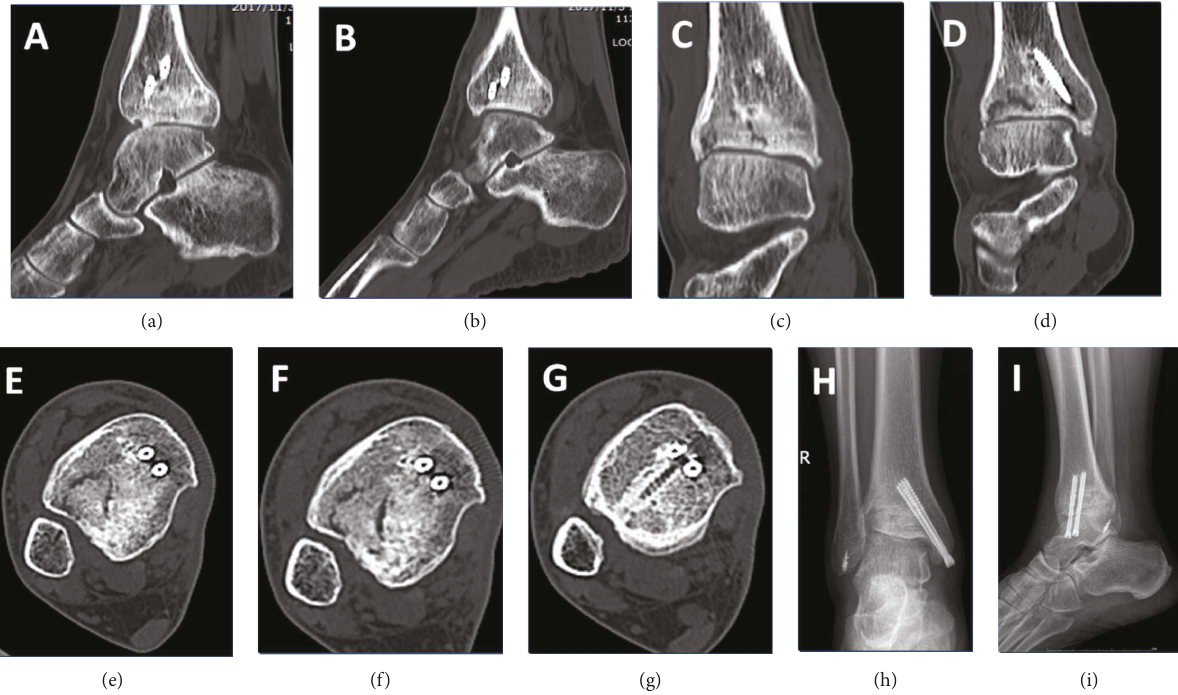
Figure 6: 12 months posttreatment: the ankle CT scanning and anteroposterior and lateral radiographs images. (a – f) Ankle CT scanning images of the right ankle. (h) Anteroposterior radiograph of the right ankle. (i) Lateral radiograph of the right ankle.